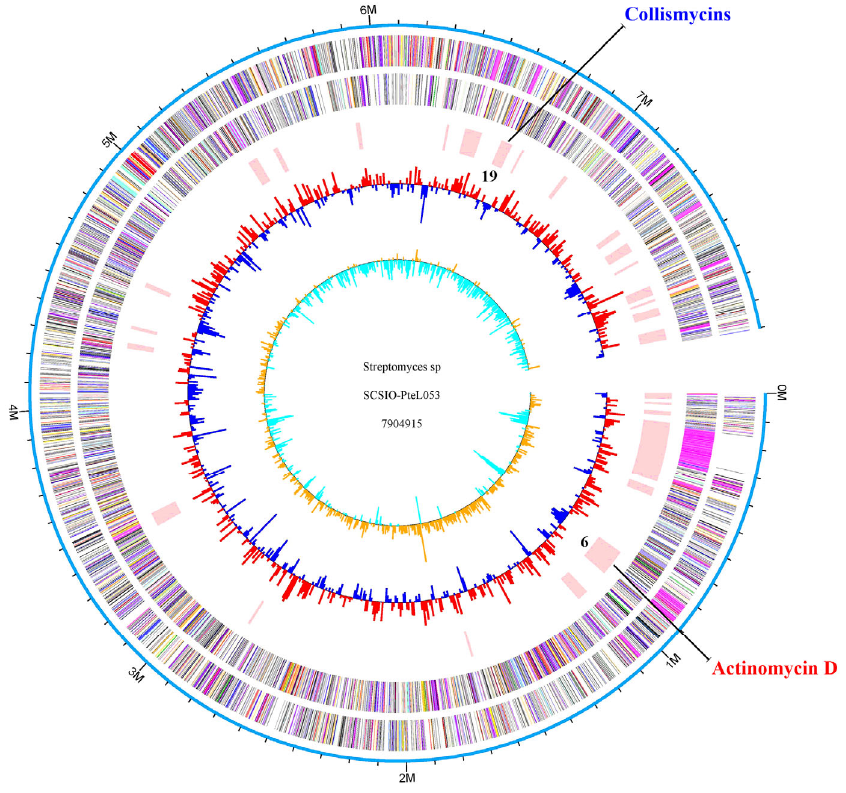
Figure 1. The whole genome of S. griseus SCSIO PteL053. The five circles (inner to outer) correspond to GC skew, GC content, putative BGC distribution, reverse strand CDSs, forward strand CDSs. Table 1. Genome features of S. griseus SCSIO PteL053.